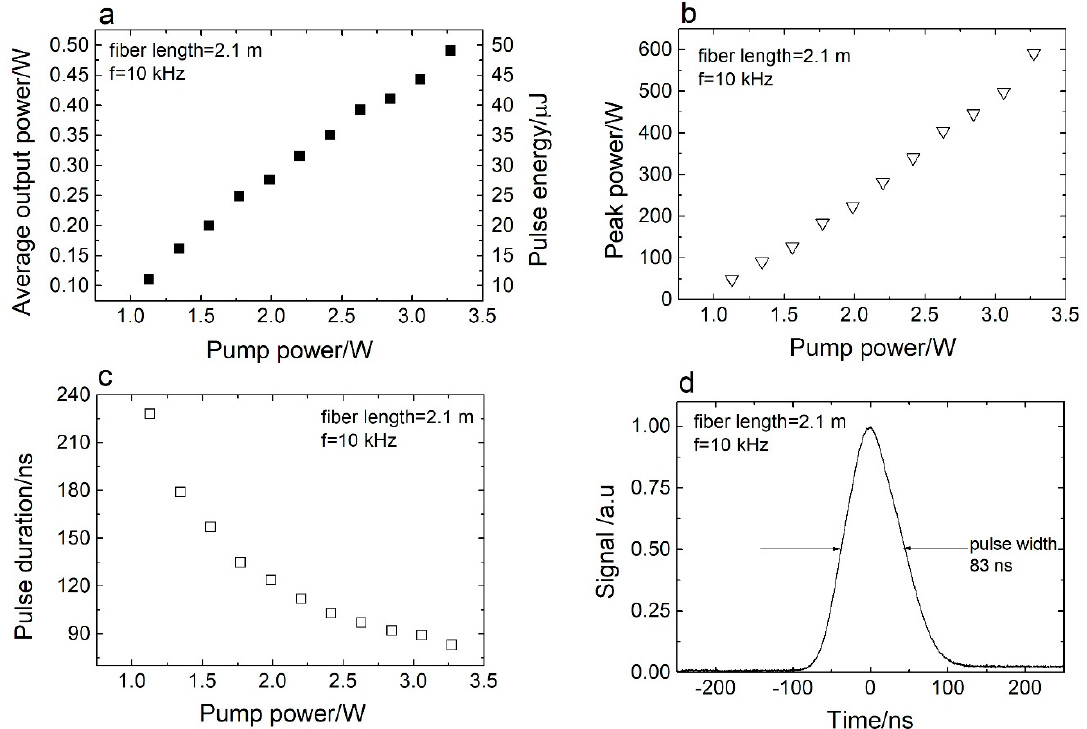
Figure 4. ( a ) Average output power and pulse energy versus pump power. ( b ) Peak power versus pump power. ( c ) Pulse duration versus pump power. ( d ) Pulse shape recorded at 10 kHz. The fiber length used in the experiment was 2.1 m.